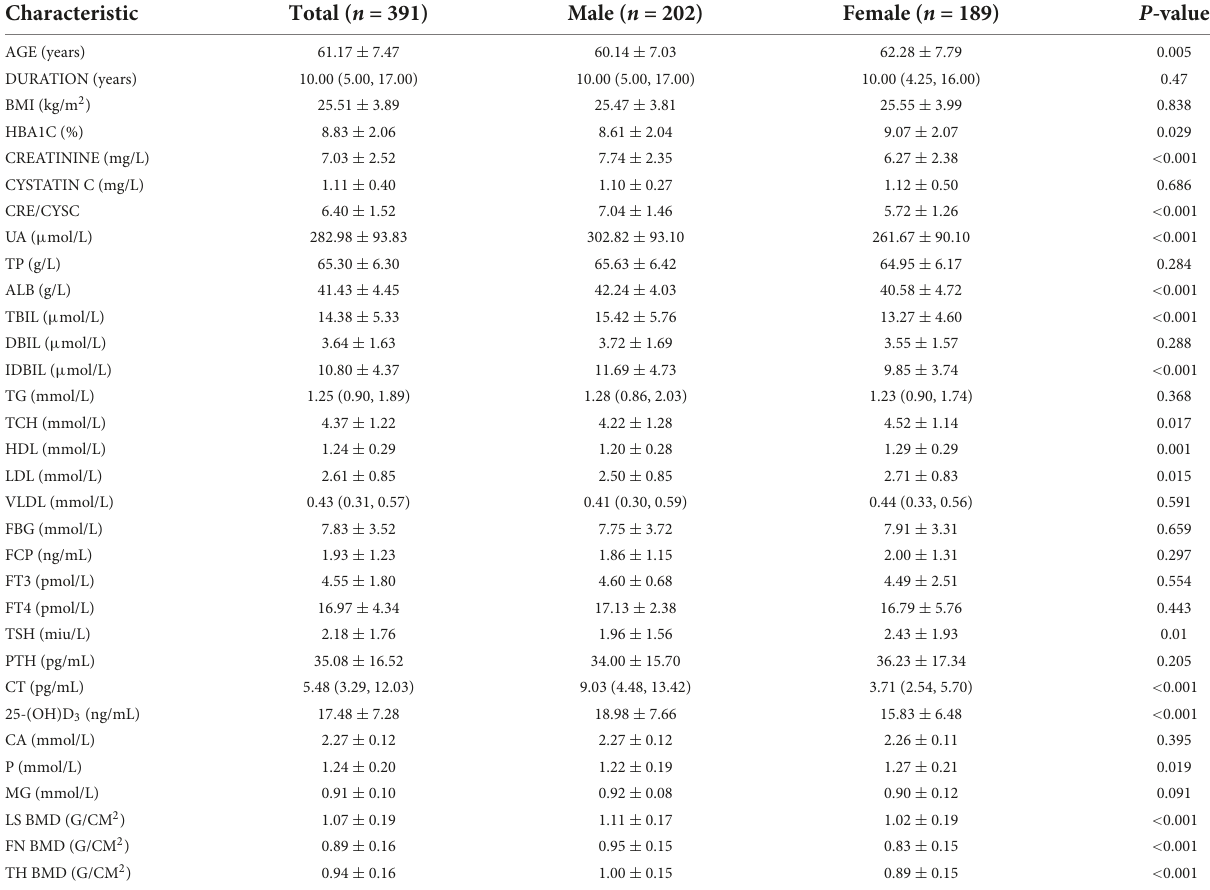
TABLE 1 Characteristics of patients included in this